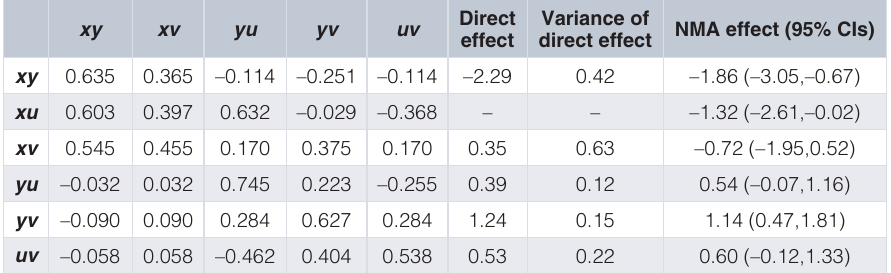
Table 1. H matrix in the network of topical antibiotics without steroids for chronically discharging ears. Columns correspond to direct comparisons and rows correspond to network meta-analysis (NMA) effects. Direct effects along with their variances and NMA effects with 95% confidence intervals (CIs) are given in the last column. Direct and NMA effects are measured as log odds ratios. Positive values favour the first treatment